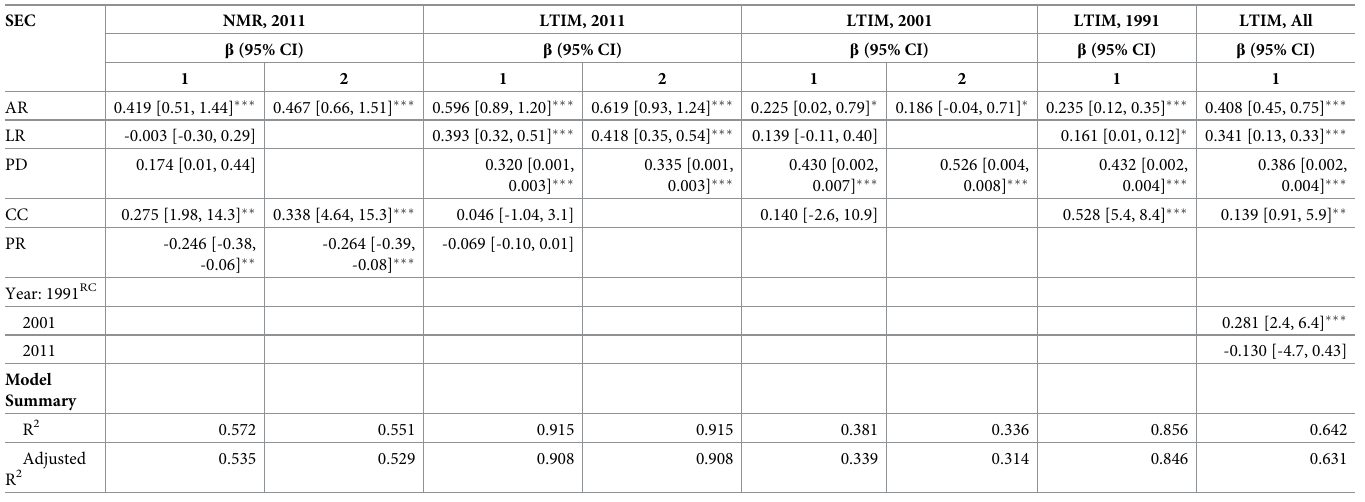
Table 4. Socioeconomic factors affecting internal migration in